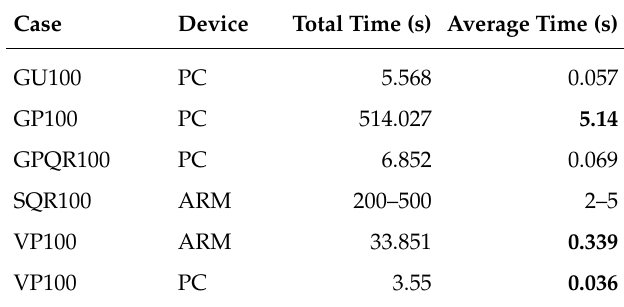
Table 3. The performance of the experiments.